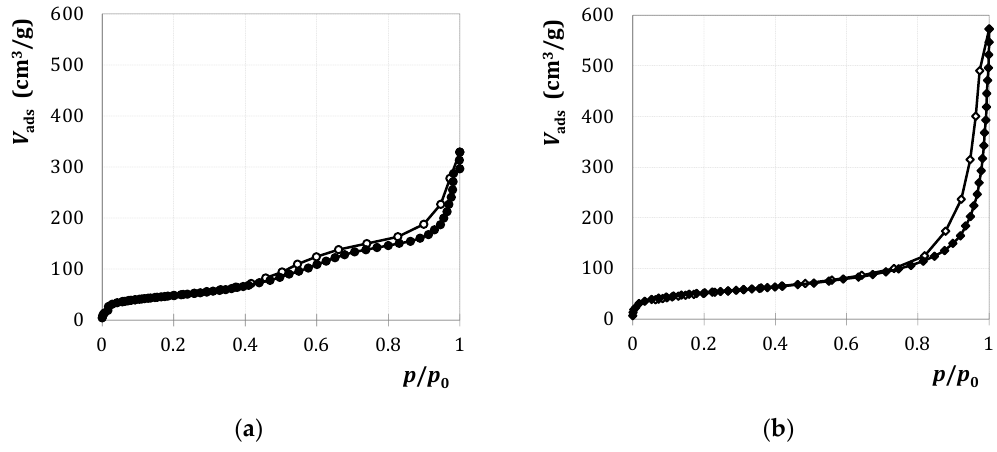
Figure 1. Nitrogen adsorption and desorption at 77 K on ( a ) M1 and ( b ) SiO 2 .